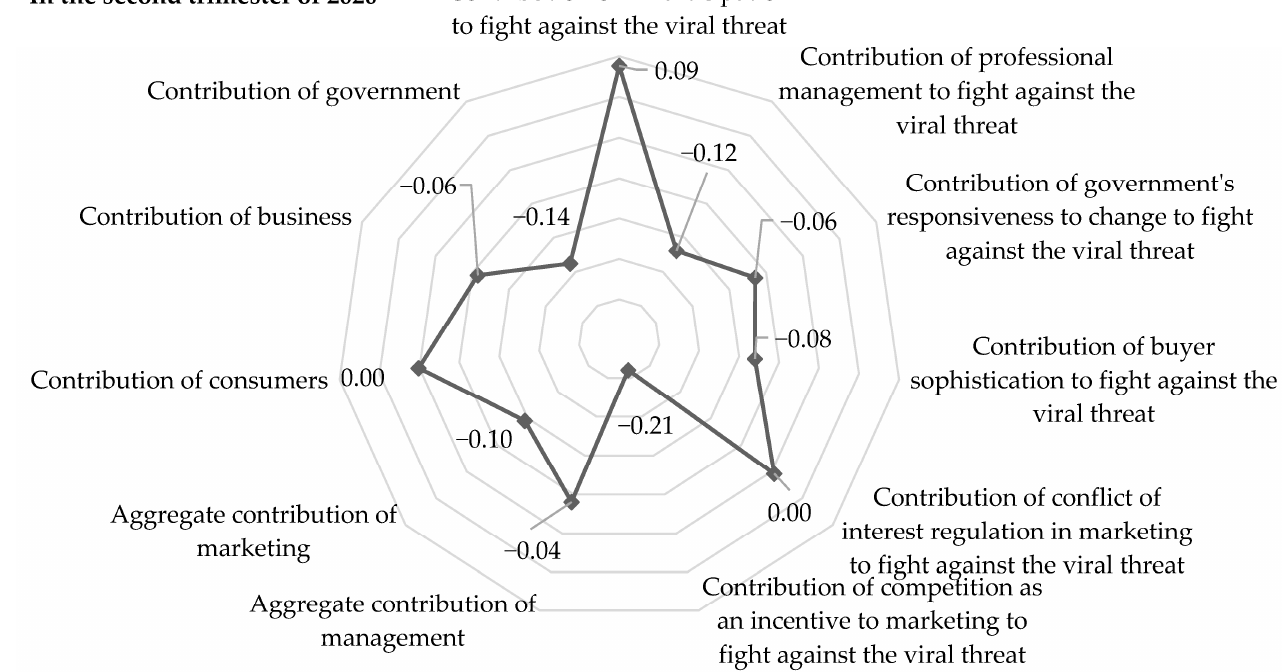
Figure 1. Contribution of management and marketing factors to the pandemic risk management in the second trimester of 2020. Source: Calculated and developed by the authors according to the dataset (Sozinova 2022).